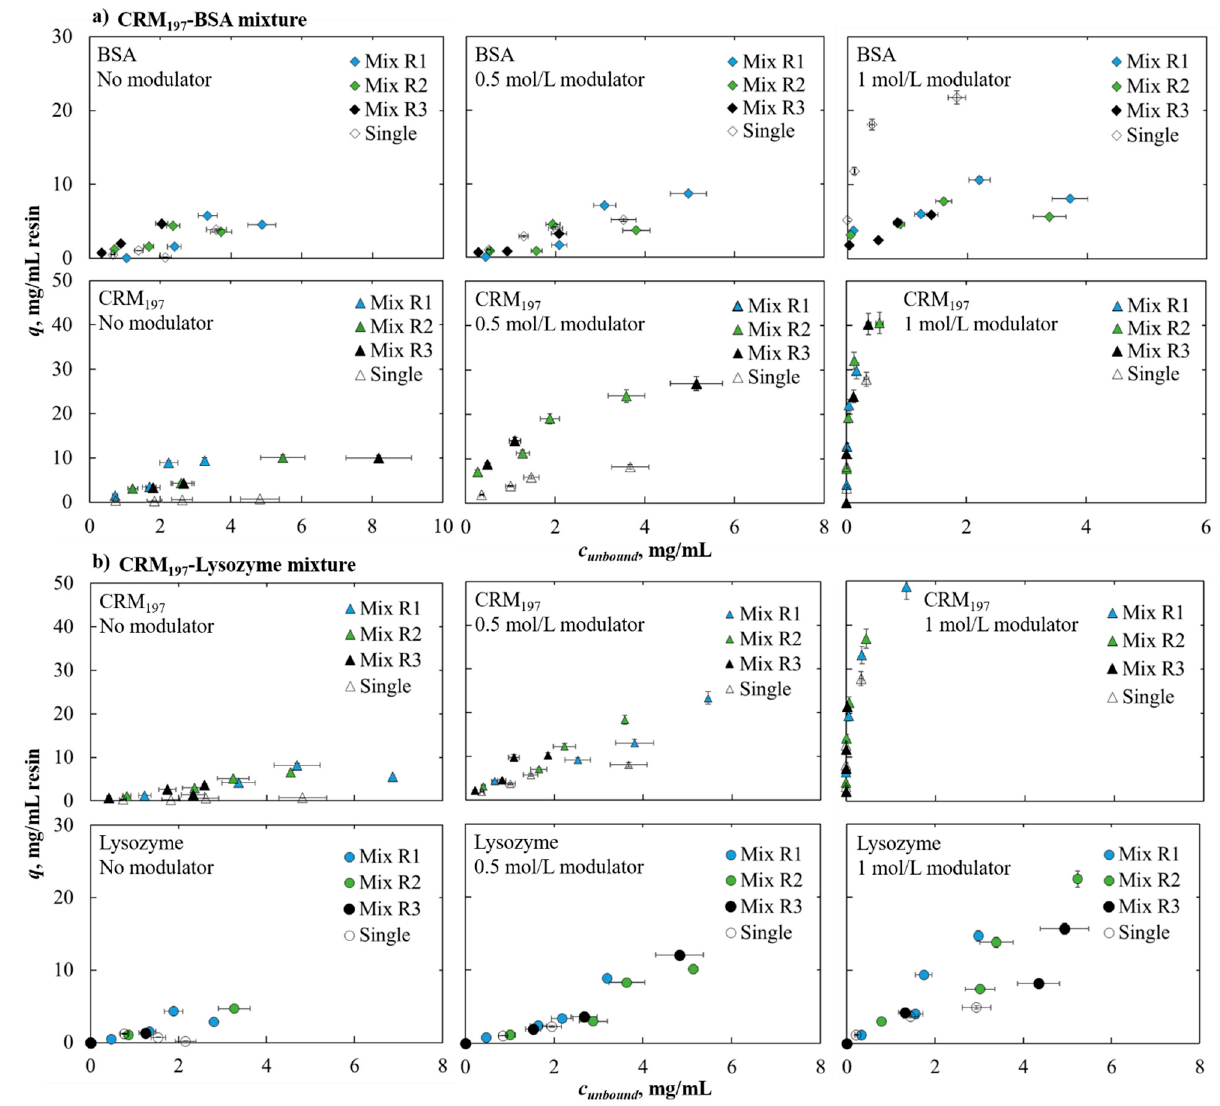
Figure 3. Adsorption isotherm comparison for binary mixtures: section ( a ) shows the mixture BSA–CRM 197 , section ( b ) shows the mixture CRM 197 –lysozyme. Each graph presents data for a fixed ammonium sulfate concentration (0, 0.5 and 1 mol/L from left to the right). In each graph, the empty symbols labelled as “Single” represent the adsorption isotherm of the protein in single-component case (see Figure 1), “Mix R1” is the protein ratio 70–30%, “Mix R2” is the protein ratio 50–50%, “Mix R3” is the protein ratio 30–70% considering that in all the ratios, the first percentage is relative to the protein shown in the upper graphs of the section and the second percentage is relative to the protein in the lower graphs of the section.